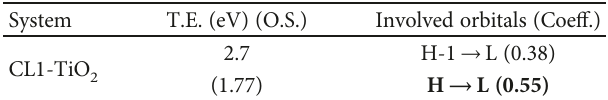
Table 6: Details of the most important transition (= λ maxTh. ) for the dye-titania complex. The calculations were done within the CAM- B3LYP approximation. Abbreviations and the use of bold font are as that of Table 5.